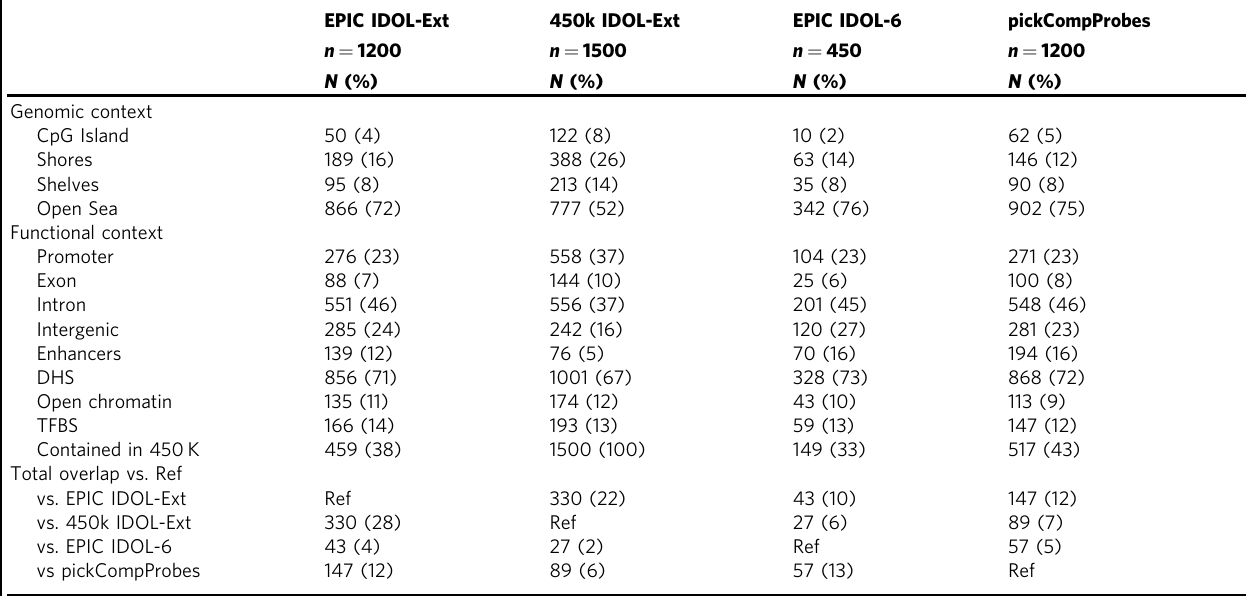
Table 1 Characteristics of the context of the different blood cell-type deconvolution